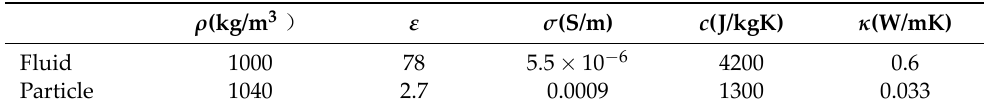
Table 1. A list of parameters used in REP